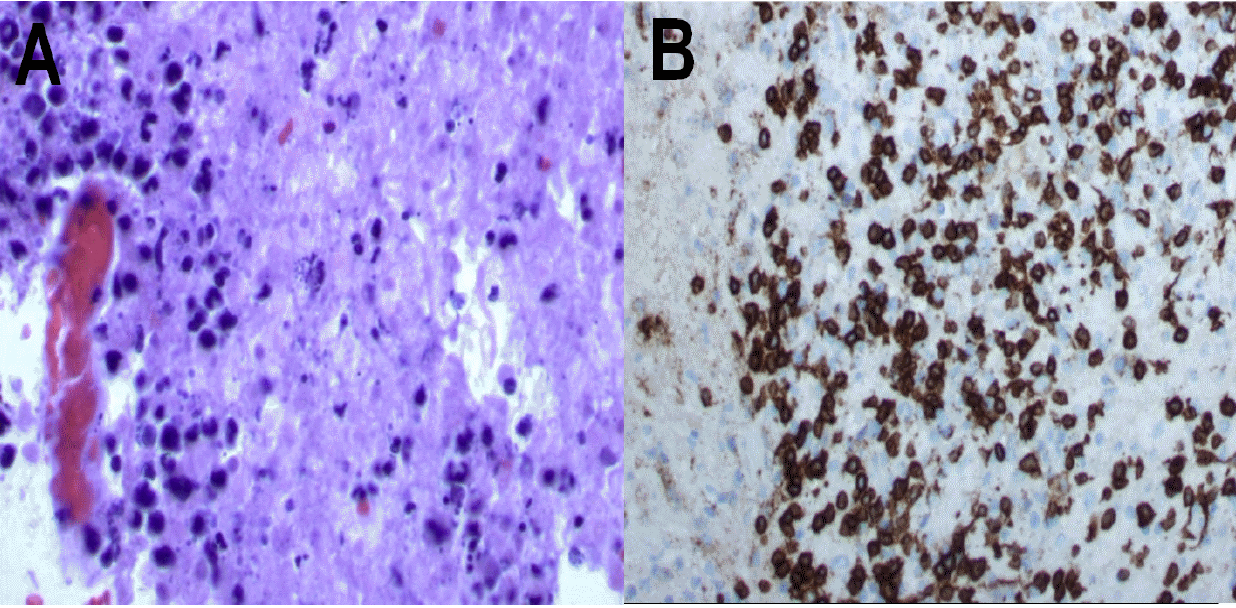
Figure 2. Brain histopathology of patient 1. Significant necrosis with perivascular mixed inflammatory cells, with lymphocyte predominance and concentric vascular wall fibroblastic proliferation. Rare individual Toxoplasma gondii bradyzoites and numerous tachyzoites were identi- fied (100X) ( A ). Immunophenotyping of the inflammatory cells, showing a mixture of mature T- and B-lymphocytes with CD8+ over CD4+ cell predominance. There was no evidence of other infections or CNS lymphoma (100X) ( B